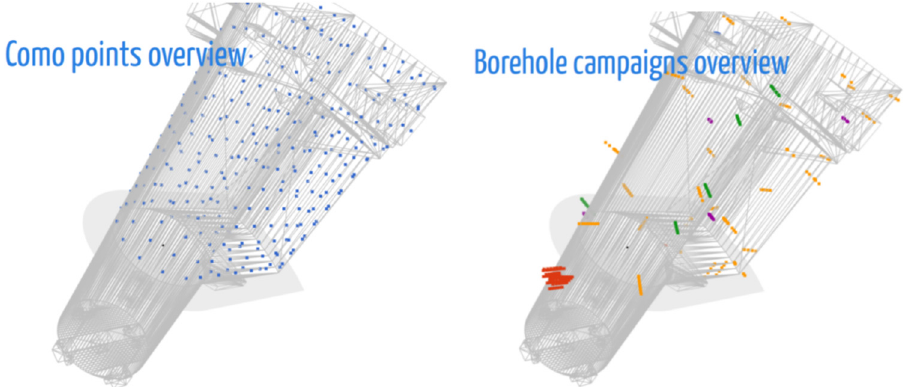
Fig. 5. Current dataset for the BR3 biological shield: in situ total gamma measurements (left, contamination monitor) and gamma spectroscopy on segments/samples (right, boreholes).